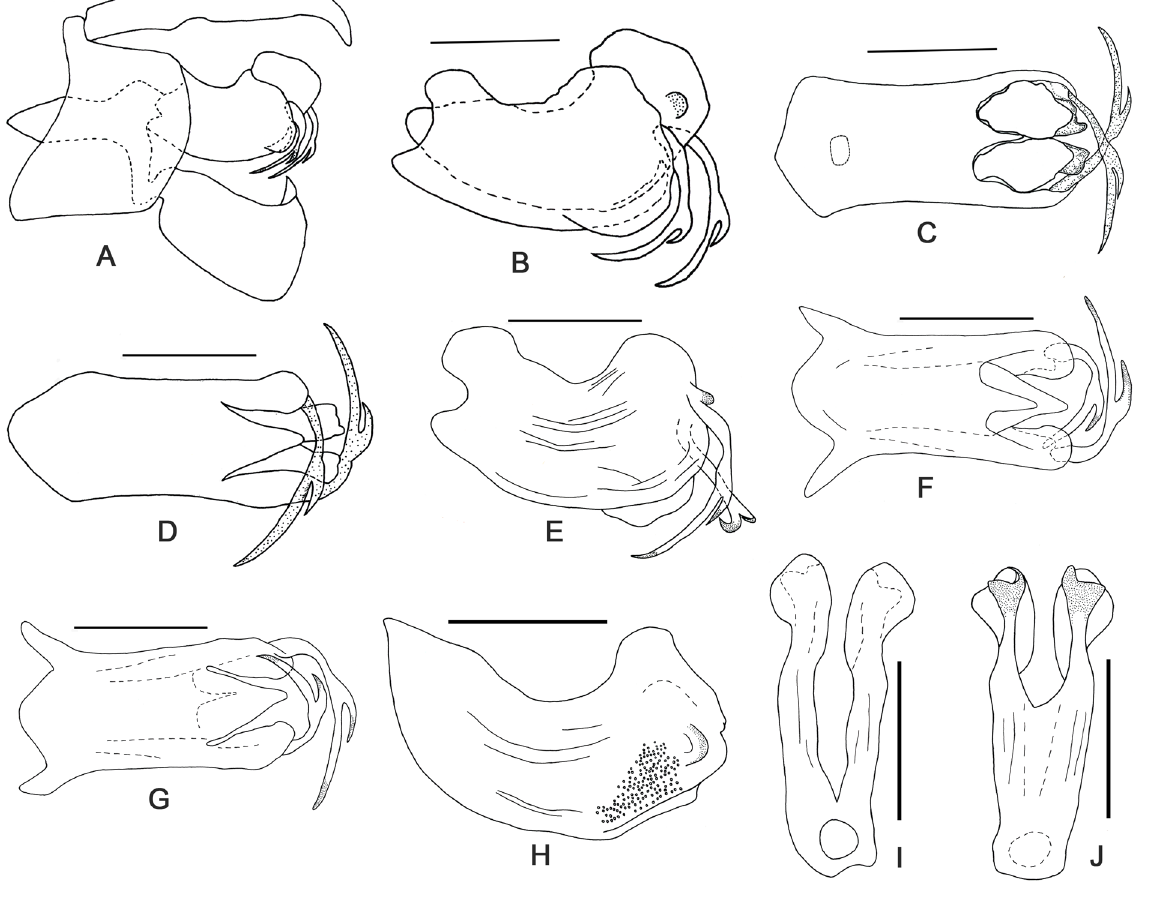
Fig. 2. Atracis ocularia sp. nov., holotype, ♂ (NWAFU). A . Male genitalia, right lateral view. B . Phallic complex, right lateral view. C . Phallic complex, dorsal view. D . Phallic complex, ventral view. E . Periandrium, right lateral view. F . Periandrium, dorsal view. G . Periandrium, ventral view. H . Aedeagus, right lateral view. I . Aedeagus, dorsal view. J . Aedeagus, ventral view. Scale bars = 0.5